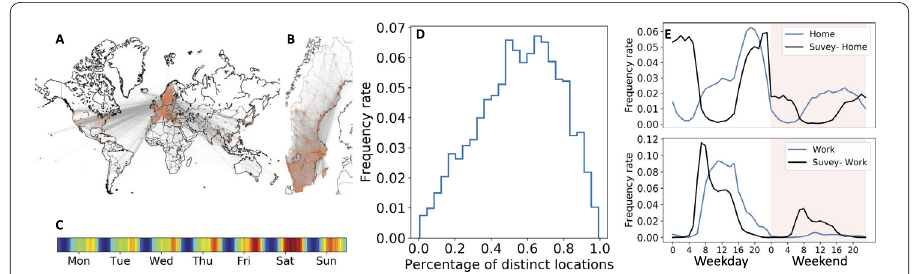
Figure 2 Characteristics of geotagged activity of Swedish users. ( A ) Geotagged activity Origin-Destination Matrix (ODM) on the map. Each point represents a region formulated by DBSCAN clustering with the distance threshold for merging as 1 km and the minimum number of location for a region is set as 1 [10, 49]. ( B ) Geotagged activity ODM on the map where the trip has both origin and destination located within Sweden. ( C ) A week-long geotagging activity pattern that captures the time-dependent characteristic of geotagged locations (average of all the users). The warmer the colour (e.g. red and orange), the higher number of geotagged locations. ( D ) The distribution of the ratio of distinct geotagged locations over total geotagged locations (individually calculated). ( E ) Daily distributions of visiting frequency of the top two most visited locations, weekday vs. weekend (adjusted by the overall distribution of geotagged tweeting frequency over seven days across a week)